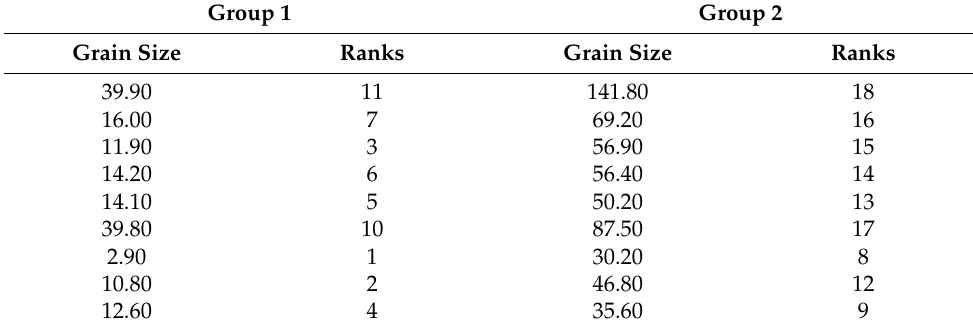
Table 3. Groups of fine and coarse grain size from nine loess